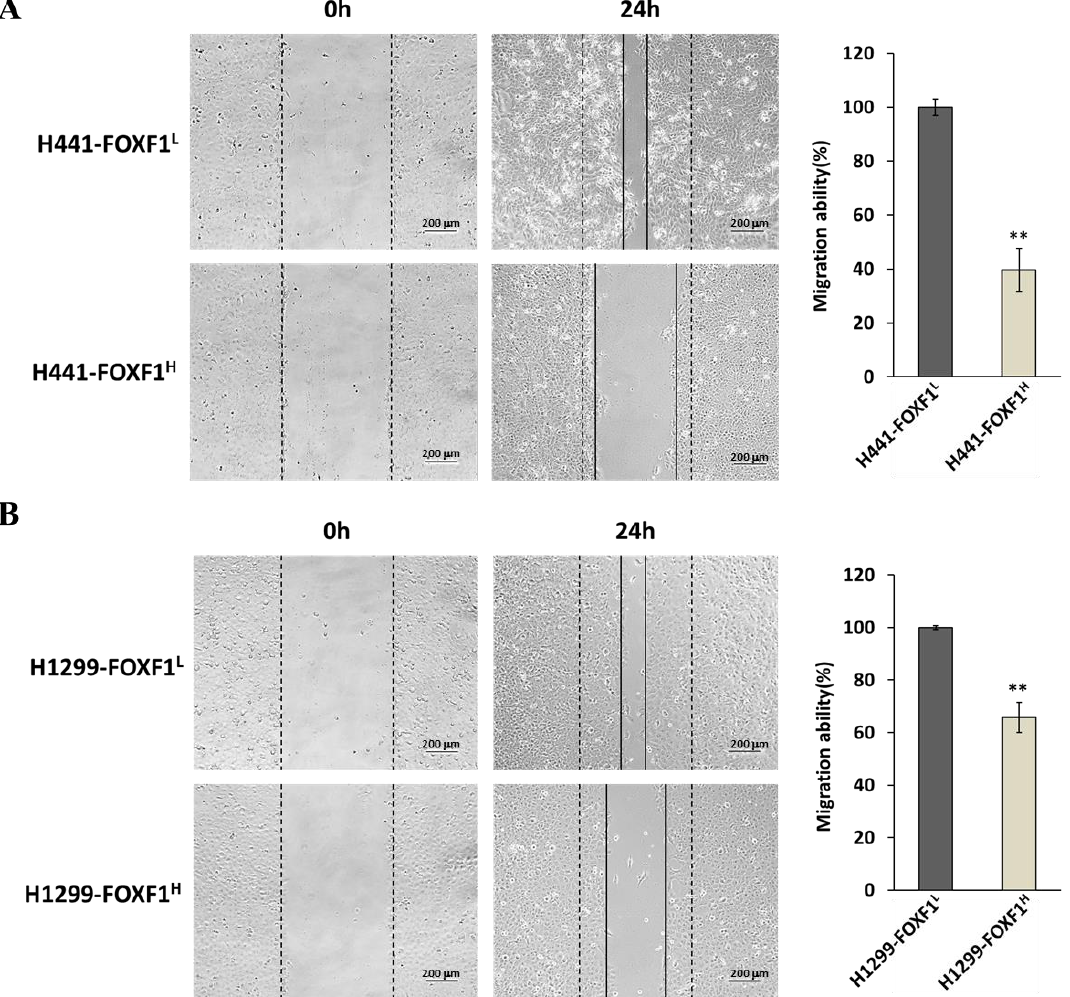
Figure 6. The effect of FOXF1 on the migration ability of non-small-cell lung cancer cell lines. The representative images and the migration area quantify the highly expressing FOXF1 cell lines and controls of H441 ( A ) and H1299 ( B ). Images were captured at 10 × magnification. Data are shown as means ± SE. ** p < 0.01, using Welch’s unpaired t- test.